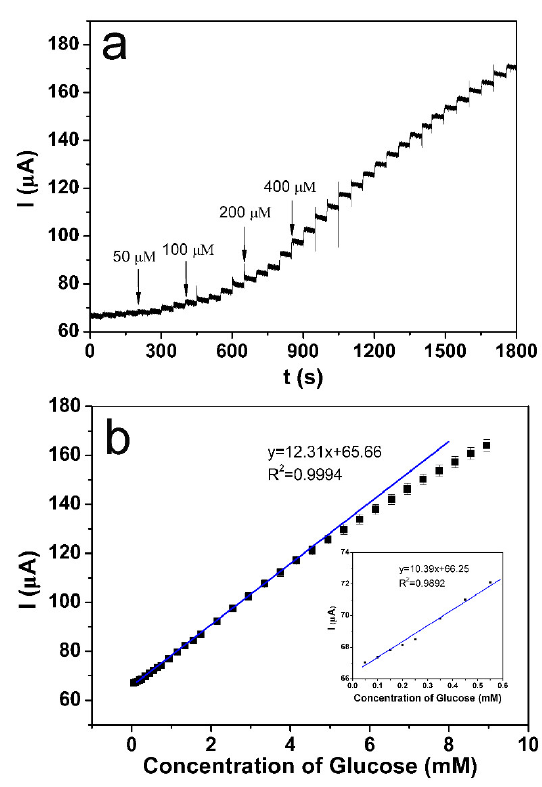
Figure 8. ( a ) Amperometric currents measured with the continuous addition of glucose with concentration from 50 to 400 μM at 0.55 V for NiFe/GO/GCE, and ( b ) the corresponding calibration curve. Inset: calibration curve at low concentrations. Table 1. Comparison of our sensor to other Ni-based sensors.